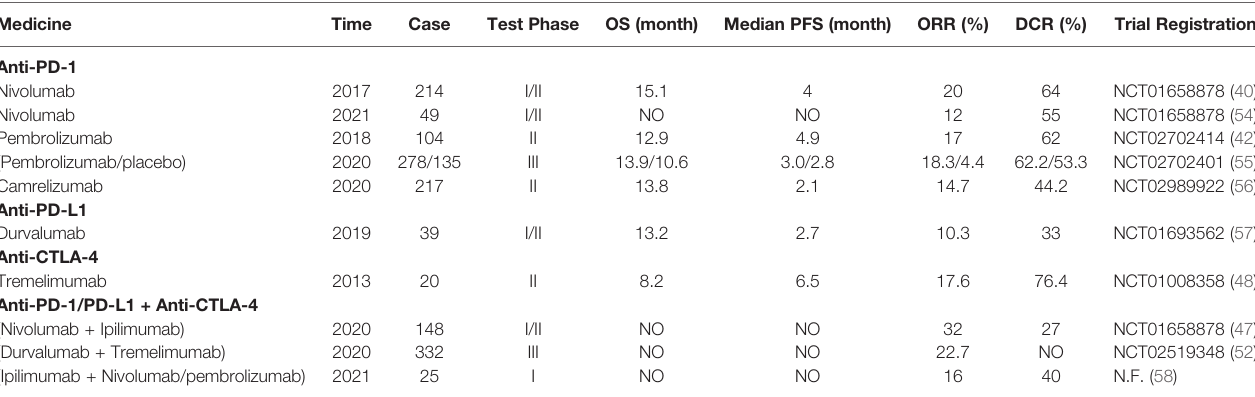
TABLE 1 | Partial research results of ICIs for